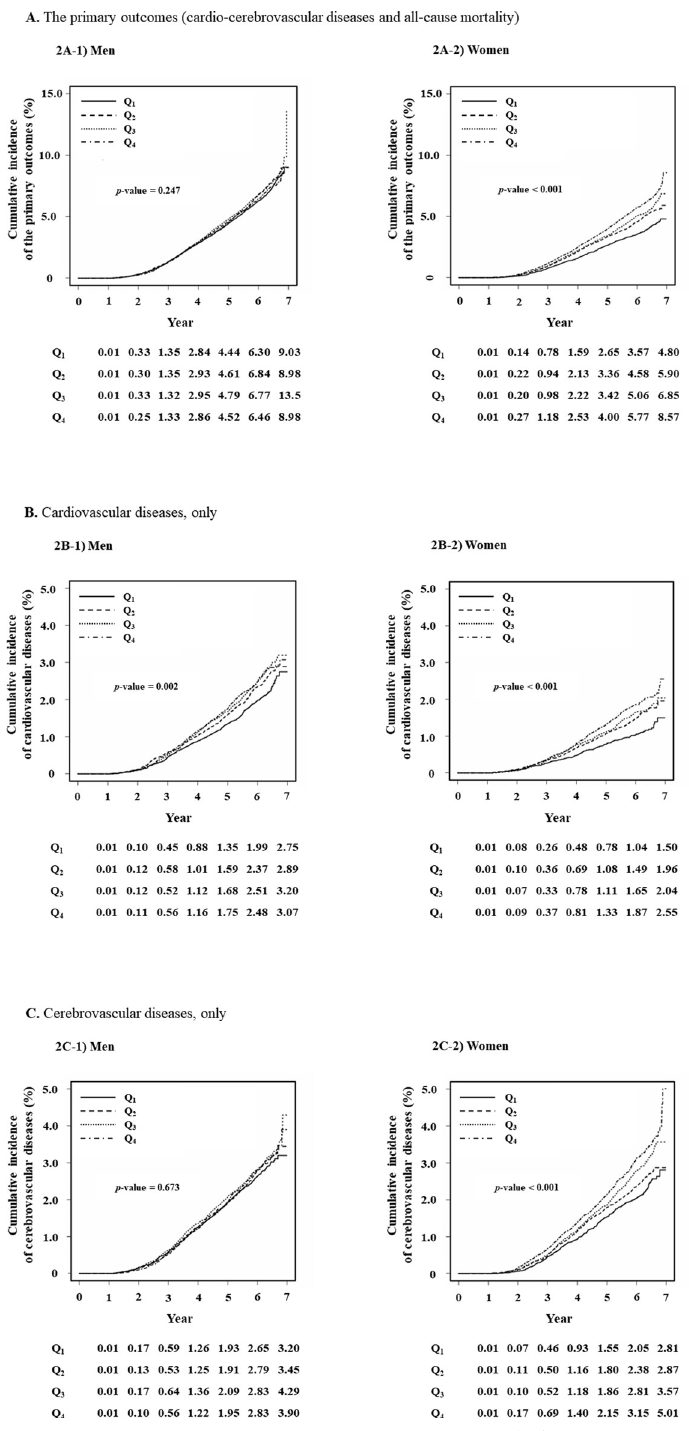
Fig 2. The estimated cumulative incidence of each outcome. A) The primary outcomes (cardio-cerebrovascular diseases and all-cause mortality). B) Cardiovascular diseases, only. C) Cerebrovascular diseases, only. All p-values are from log-rank